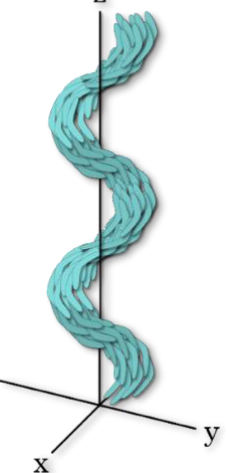
Figure 10. A schematic representation of the twist-bend nematic, N TB , phase. Odd-membered liquid crystal dimers with their bent molecular structures (Figure 1b) provided the ideal testbed for Dozov’s prediction, and some ten years later, Cestari et al. reported the discovery of the N TB phase in 1,7- bis (4-cyanobiphenyl- 4′ -yl)heptane (CB7CB) [1]: